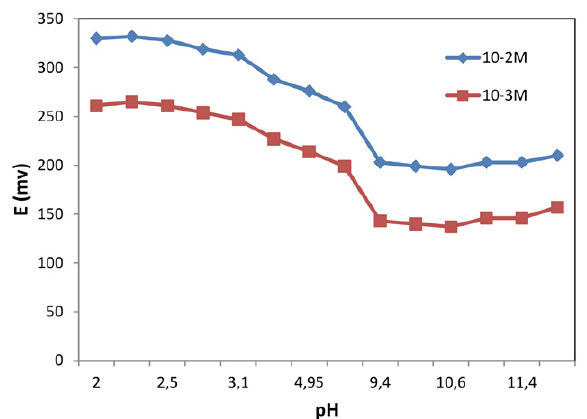
Fig. 4. Effect of pH on the response of Lab sensor 1b